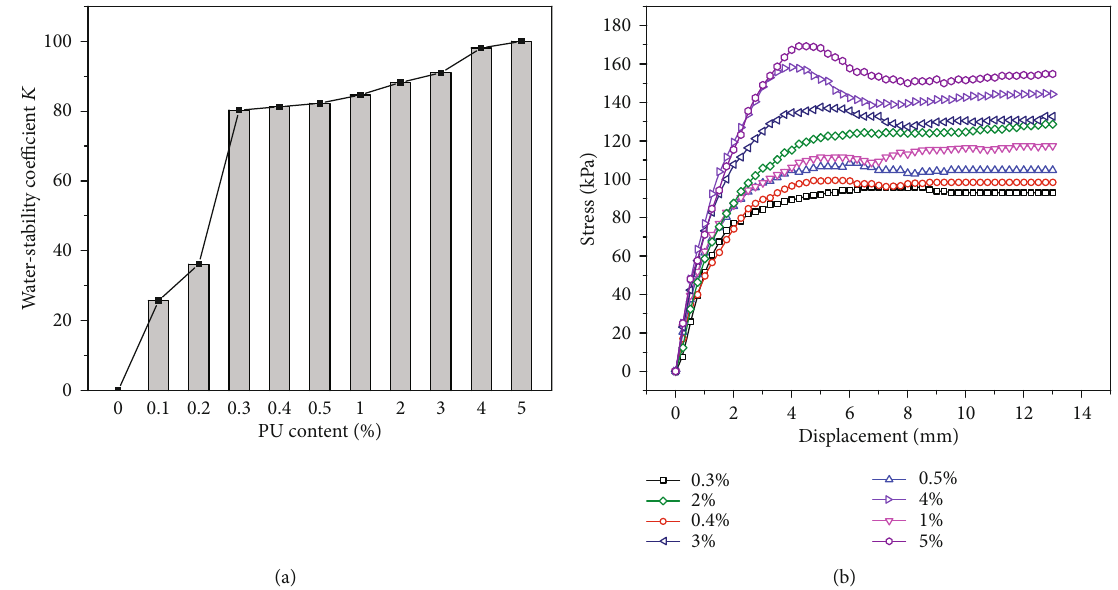
Figure 3: (a) The e ff ect of PU content on the water-stability coe ffi cient; (b) the typical direct shear stress-displacement